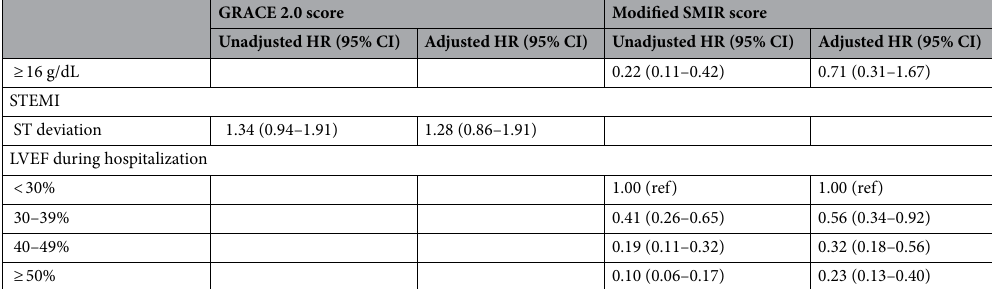
Table 2. Unadjusted and adjusted hazards ratios for the individual components of the GRACE 2.0 and modified SMIR scores among the AMI patients in SMIR (n = 1698). CI confidence interval, CPR